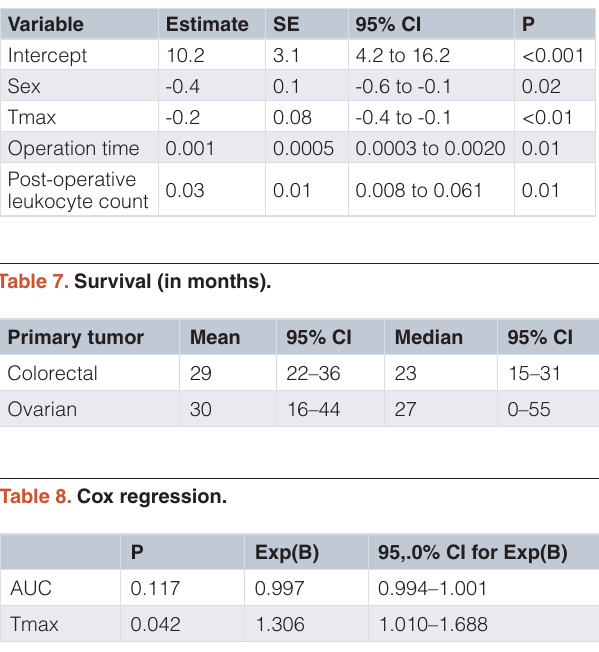
Table 6. Model predicting the logarithm of time to removal of nasogastric tube (TRNT) (dispersion parameter 0.3 (95% CI 0.2 to 0.5), scaled deviance 94.9 on 88 degrees of freedom).